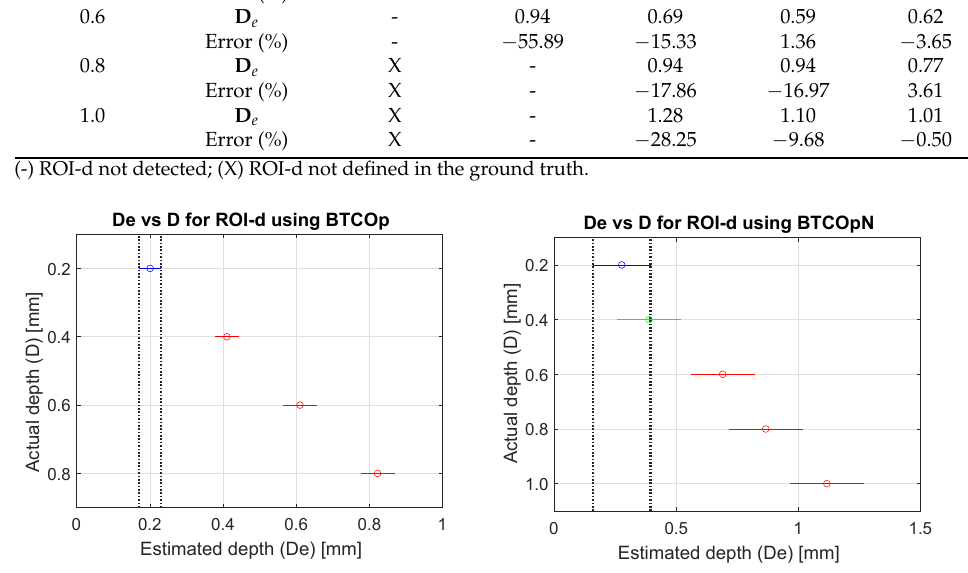
Figure 7. Analysis of variance (ANOVA) of estimated depth ( D e ) and actual depth ( D ) of defects for maxigrams of actual CFRP sequences processed using (Column 1) BTCOp method and (Column 2) BTCOpN